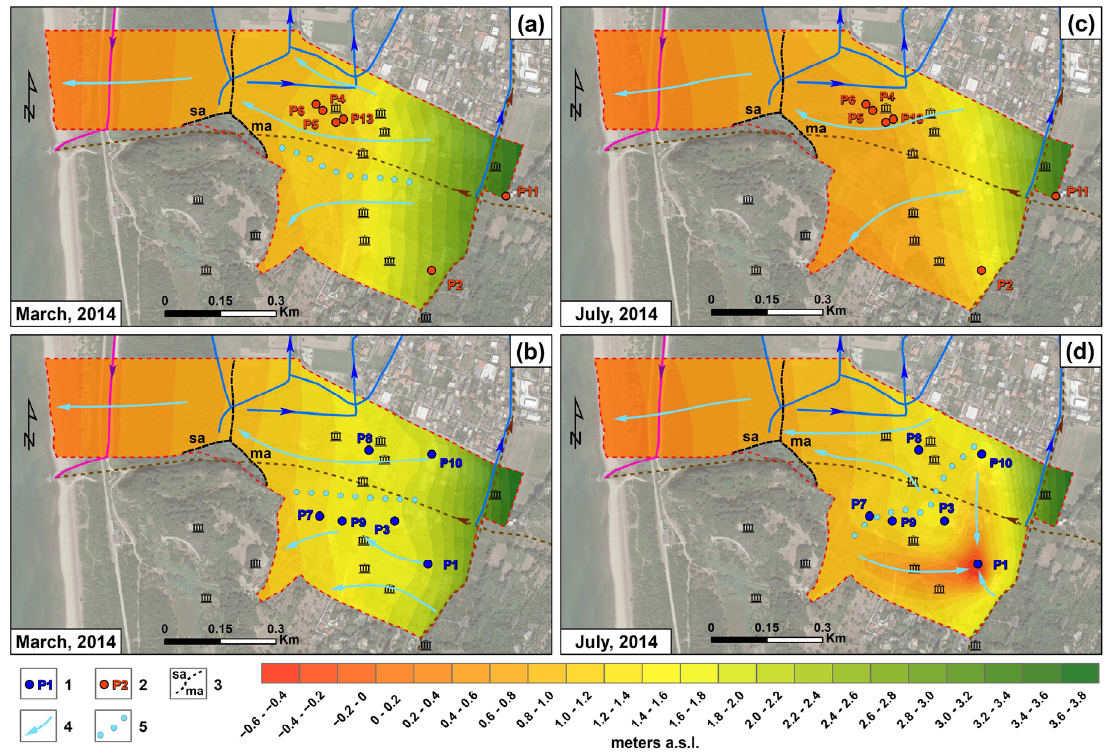
Figure 3. Groundwater flow patter in March 2014 ( a , b ) and July 2014 ( c , d ) for the shallow ( a , c ) and deep ( b , d ) aquifer. Legend: (1) Deep well; (2) shallow well; (3) hydrogeological limit between the single phreatic (sa) and the multilayered (ma) aquifer; (4) groundwater flow direction; (5) groundwater